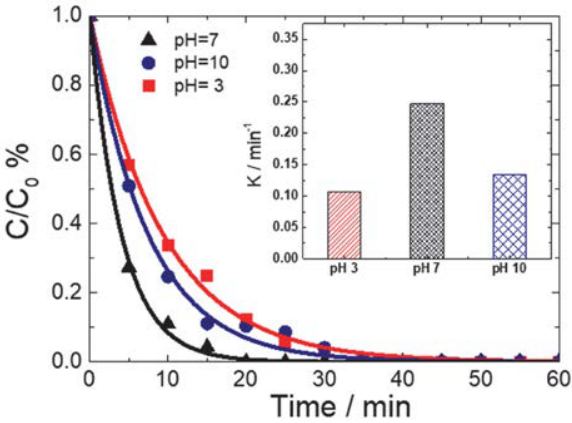
Figure 5: Concentration of imazapyr as a function of time for differ- ent pH, C(Imazapyr) = 5 μΜ ); stirring speed = 1000 min –1 , m TiO 2 = 100 mg). aqueous suspension 1 : 3 acetone/ Milli-Q